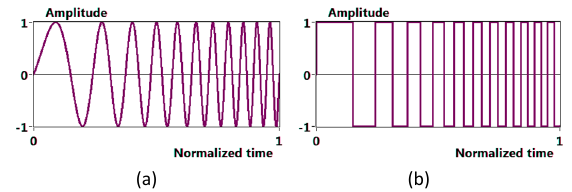
Fig.6: Waveforms of the sinusoidal (a) and signum-chirp (b). The dependency of the mean RMS magnitudes on a number of frequency bins k of chirp signals is described in